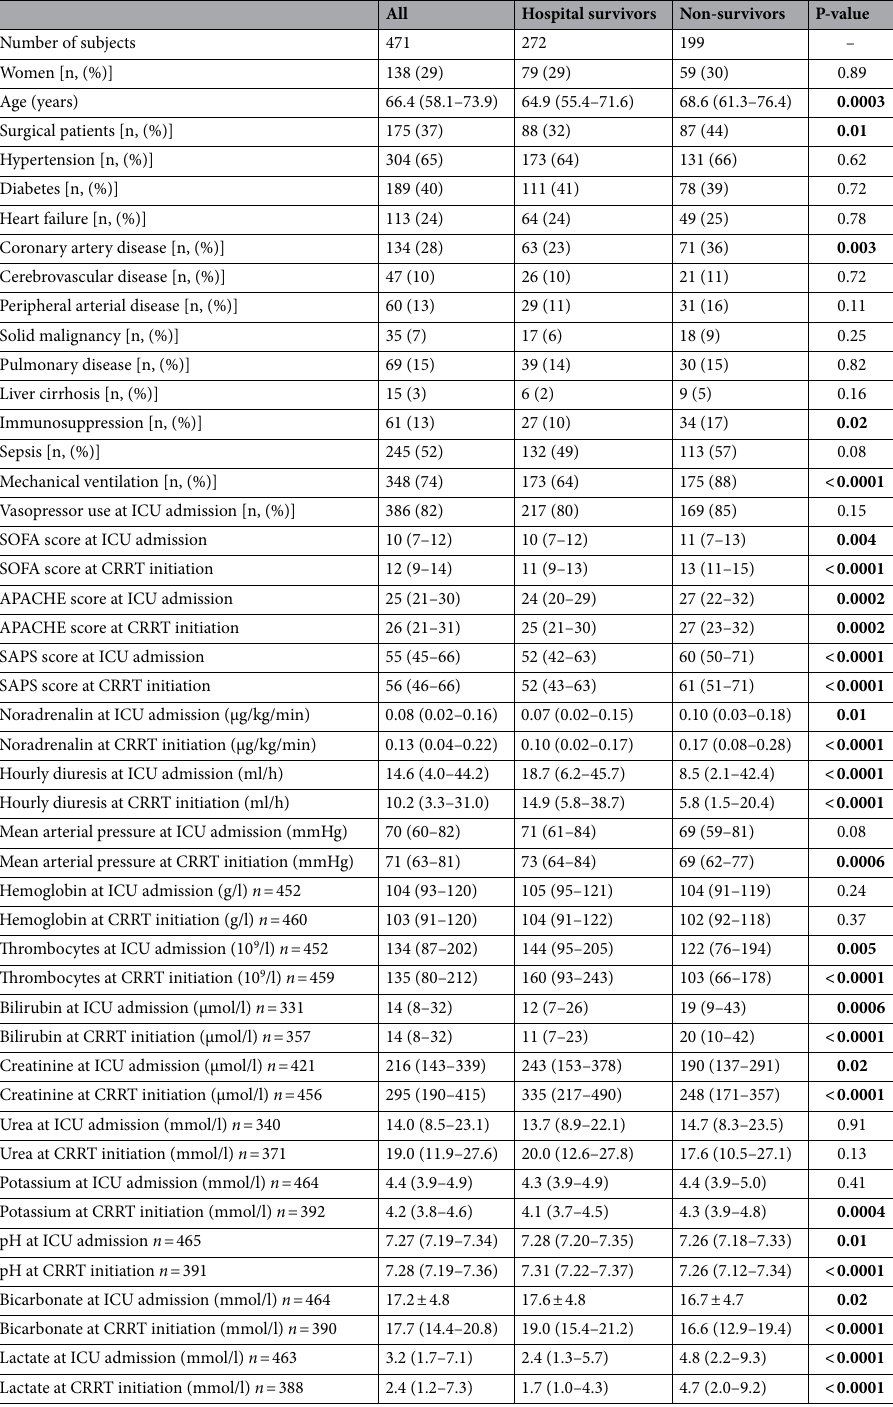
Table 1. Characteristics of the study patients. Categorical values in parentheses are % unless stated otherwise. Continuous variables are expressed as mean (± SD) or median (IQR) for normally distributed and skewed covariates, respectively. Hypertension was defined as a clinical diagnosis of hypertension and cerebrovascular disease as a diagnosis of ischemic or hemorrhagic stroke or transient ischemic attack observed in the patient records, respectively. Heart failure was defined as a clinical diagnosis of congestive heart failure observed in the patient records or ejection fraction < 50% or diastolic heart failure observed in echocardiography. Pulmonary disease was denoted as a prior diagnosis of asthma, chronic obstructive pulmonary disease or chronic interstitial lung disease. Coronary artery disease and peripheral arterial disease were defined as previously diagnosed conditions. ICU intensive care unit, SOFA-score Sequential Organ Failure Assessment score, CRRT continuous renal replacement therapy, APACHE Acute Physiology and Chronic Health Evaluation II score, SAPS Simplified Acute Physiology II score. Significant values are in